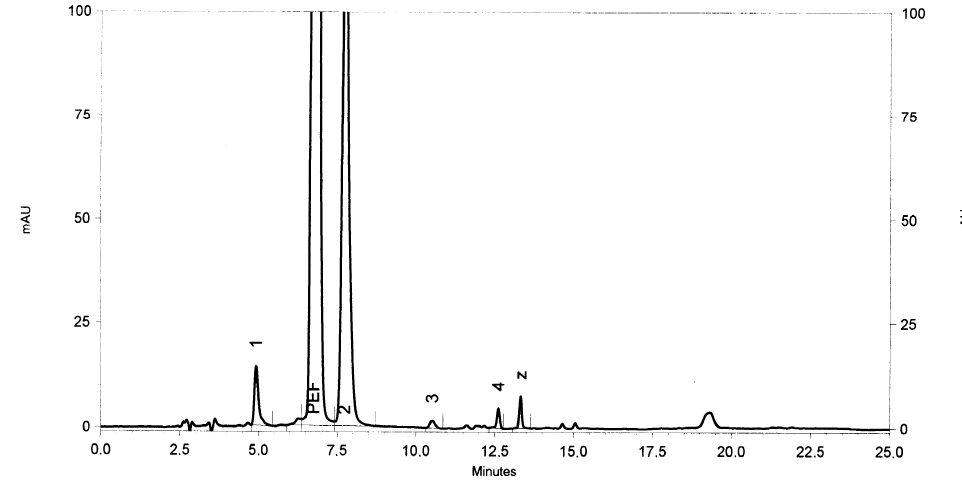
Figure 7. Chromatogram of the PEF oxidized by ACVA after incubation for 96 h at 50 °C.